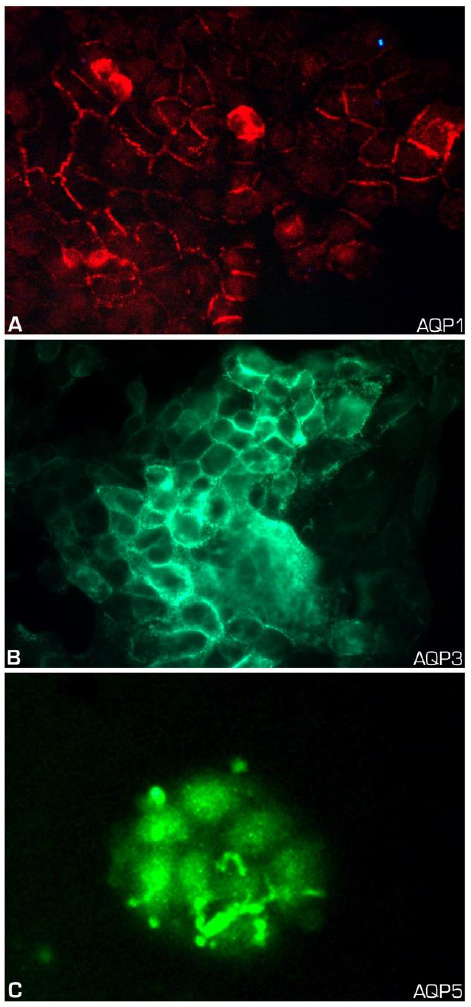
Figure 3. Expression of AQPs in mucoepidermoid carcinoma cell line (UM-HMC-3A). ( A ) Membrane expression of AQP1 in MEC cultured cells (original magnification × 400); ( B ) Membranous expression of AQP3 in MEC cells (original magnification × 400); ( C ) Rudimentary AQP5 expression in a few membrane foci in MEC cells (original magnification ×